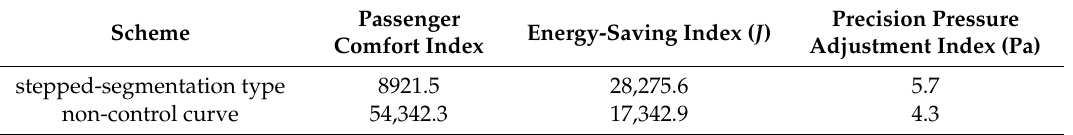
Table 4. Comparison results between the optimal stepped-segmentation curve and the non-control curve.